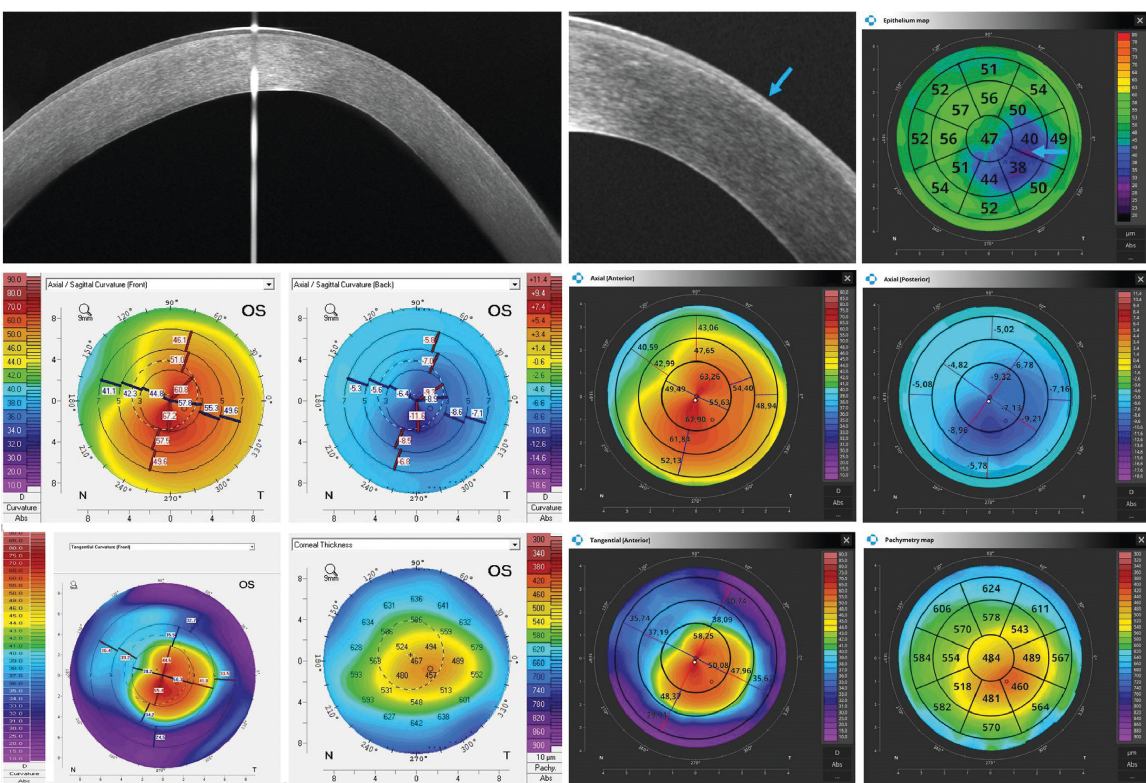
Figure 4: Cornea with keratoconus. The decrease in corneal epithelial thickness (blue arrow) corresponds to the increase in corneal thickness on the pachymetry map. Topography maps show that both the anterior and posterior corneal surfaces have irregular curvature. The measurements performed with Pentacam have a white background, and the ones performed with the REVO NX have a black background. The K1, K2, and astigmatism values for the anterior surface of the cornea obtained using Pentacam are 51.0D, 62.9D, and 11.9D, respectively, while the values obtained using the REVO NX are 50.9D, 61.9D, and 11.0 D, respectively. The values of analogous parameters for the posterior corneal surface from Pentacam are − 7.7D, − 9.7D, and 2.0 D and the values from REVO NX are − 7.2D, − 9.4D, and